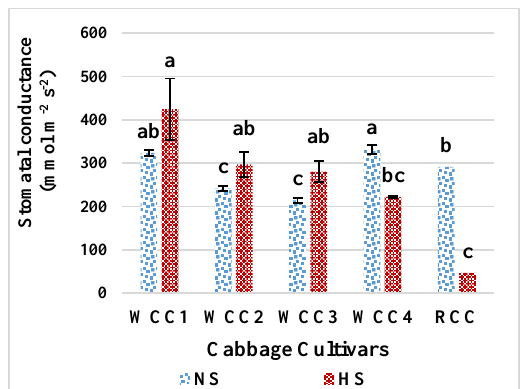
Figure 3. Mean phenotypic expression of stomatal conductance (mmol m −2 s −1 ) of five cabbage cul- tivars under HS (at 42 °C; for 5h) and NS (25 °C) conditions. Bars denote the mean of at least 4 measurements ± SE. Mean values within each cultivar with different letters are significantly differ- ent based on Tukey’s HSD test at p < 0.05.